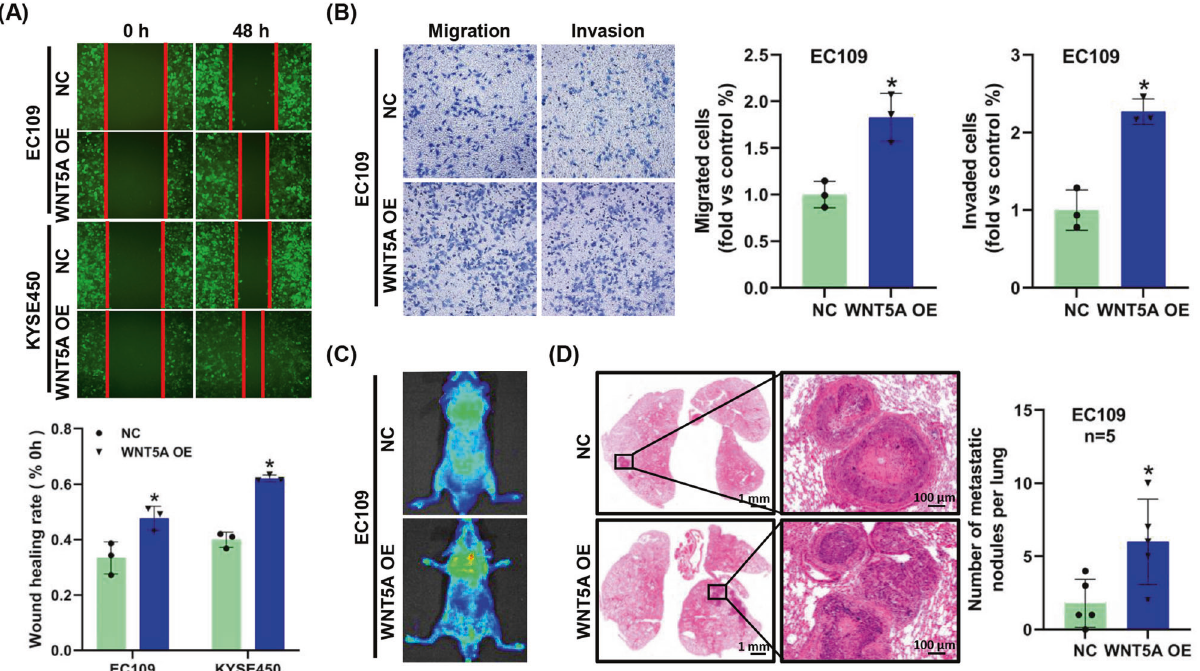
Fig. 3 WNT5A overexpression facilitates the migration, invasion, and metastasis of ESCC cells. A , B Representative images and statistical analysis of wound healing assays and Transwell migration/invasion assays using EC109 or KYSE450 cells overexpressing WNT5A. The migratory ability in wound healing assays was expressed as the mean scratch area. The initial scratch area (0 h) was set to 100%. C Representative fl uorescence images of nude mice 7 weeks after the tail vein injection. D Representative images of HE staining of lung samples and statistical analysis of the metastatic nodules per lung from the indicated groups ( n = 5 per group). Scale bars, 1 mm and 100 μ m (inset). * P < 0.05 compared with the NC